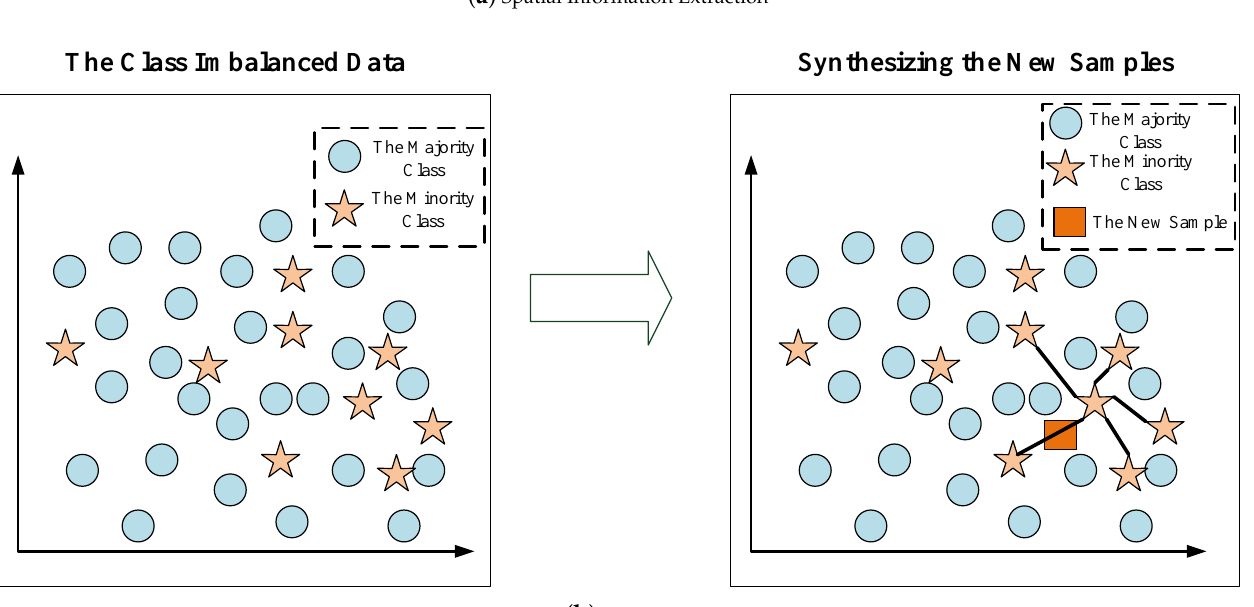
Figure 1. The Flow Chart of Spatial Information Extraction and Balanced Datasets